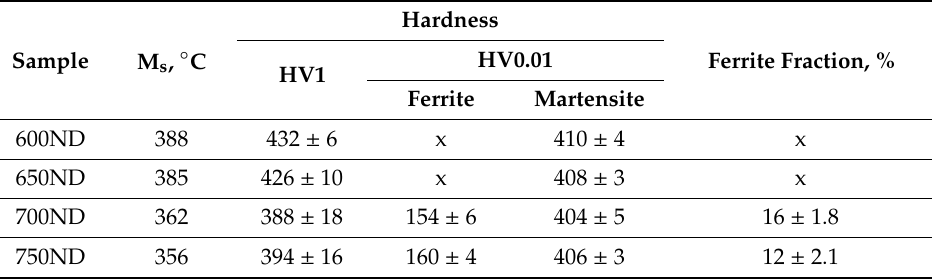
Table 3. Experimental results of non-deformed